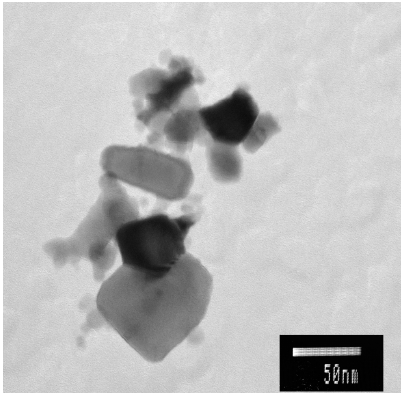
Figure 1. Transmission electron microscope (TEM) images of zinc oxide nanoparticles (ZnO NPs) stock solution (50 mg L − 1 ).